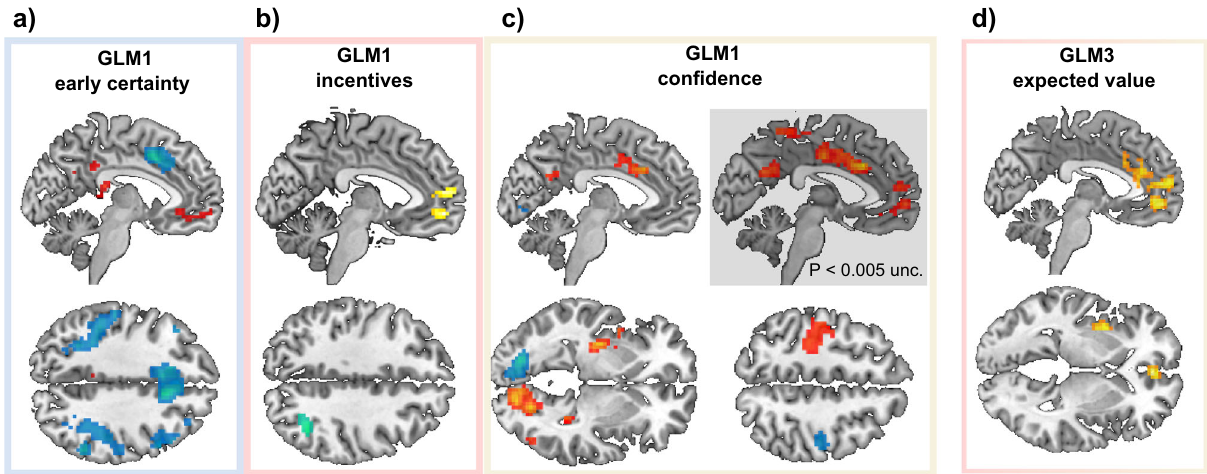
Fig. 3 Whole-Brain fMRI Results. a – c Whole-brain statistical blood-oxygen-level-dependent (BOLD) activity correlating with general linear model 1 (GLM1) “ early certainty ” ( a ), incentives ( b ), and con fi dence ( c ). d Whole-brain statistical maps of BOLD activity correlating with GLM3 “ expected value ” . N = 30. Unless otherwise speci fi ed, all displayed clusters survived p < 0.05 family-wise error (FWE) cluster correction. Voxel-wise cluster-de fi ning threshold was set at p < 0.001, uncorrected. Red/yellow clusters: positive activations. Blue clusters: negative activations. For whole-brain activation tables see Supplementary Data